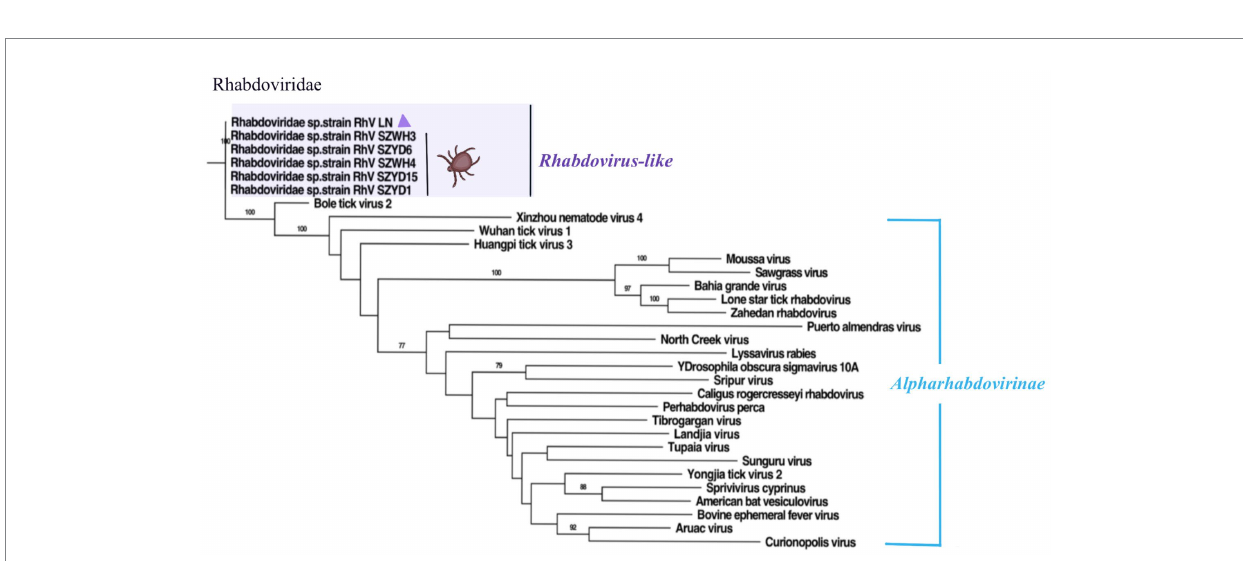
FIGURE 5 Phylogenetic trees of RhV/LN (340 aa) based on RdRp of members within Rhabdoviridae. Nodes with bootstrap values >70 are noted. Scale bars indicate substitutions per site. Animal icons represent host species. Purple triangles-marked strains were found in this